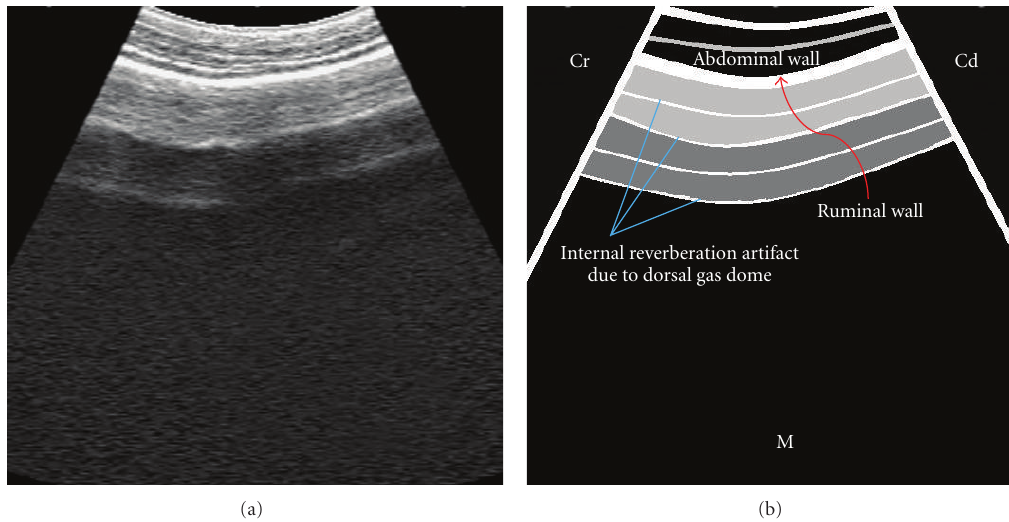
Figure 1: Ultrasonogram of the rumen obtained from dorsal left paralumbar fossa, by placing the transducer parallel to the longitudinal axis of the cow. Cr: cranial, Cd: caudal, and M: medial.